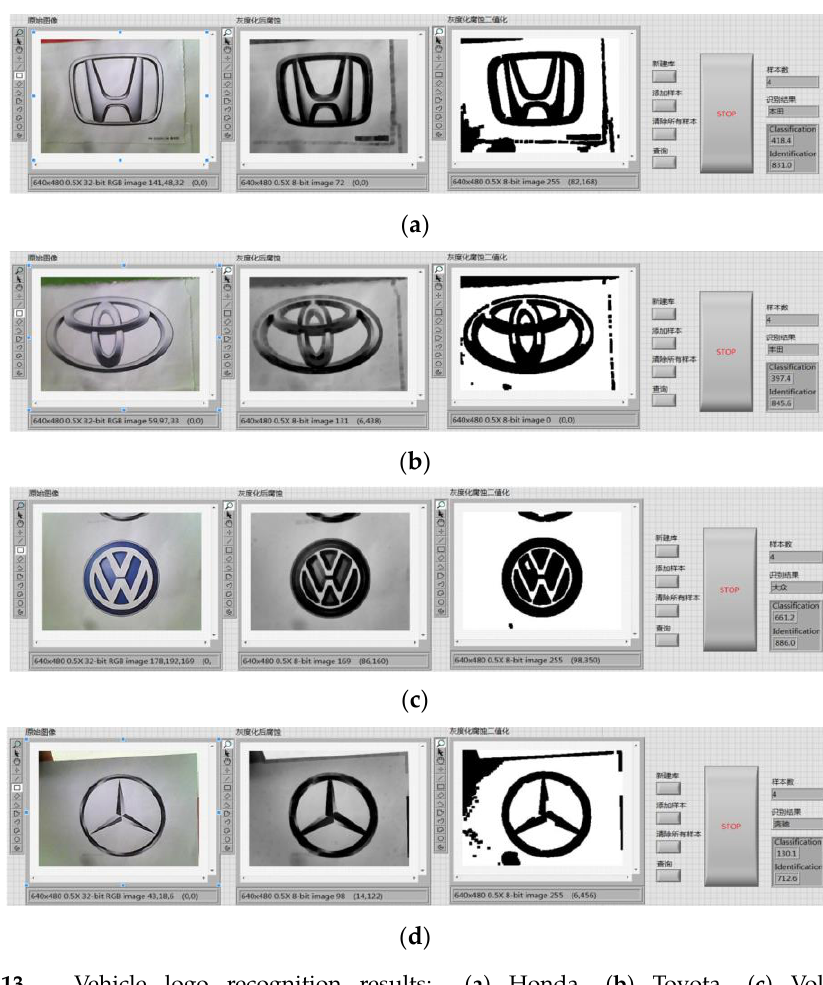
Figure 13. Vehicle logo recognition results: ( a ) Honda, ( b ) Toyota, ( c ) Volkswagen, and ( d ) Mercedes- Benz.